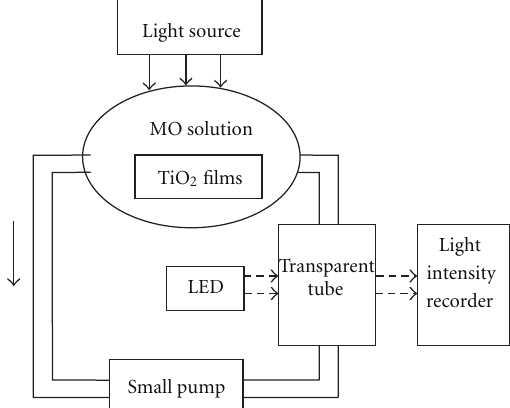
Figure 4: The schematic diagram of experimental setup for automatic detecting the photodecomposition rate. The whole setup is put in an aluminum box. The data record interval can be set from 1minute to 1hour. MO solution: methyl orange